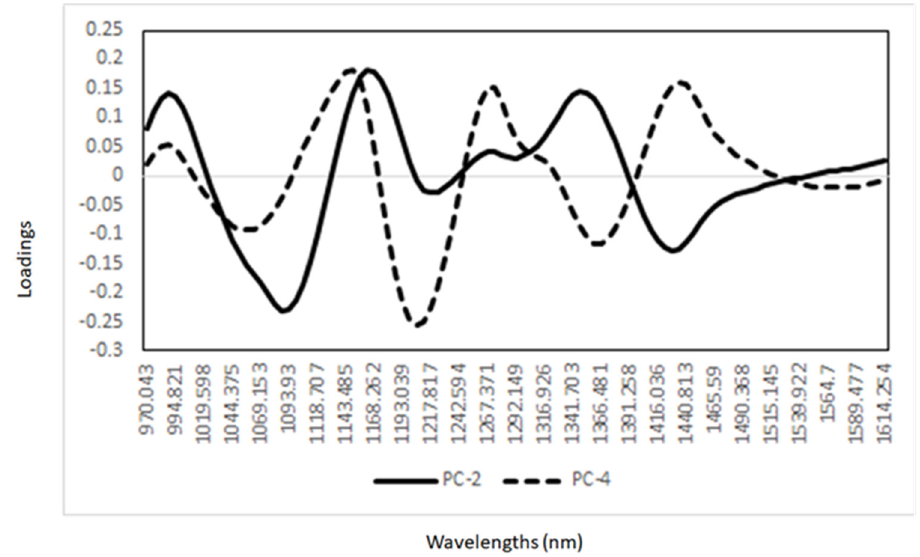
Figure 3. Principal component loadings derived from the analysis of minced meat samples.